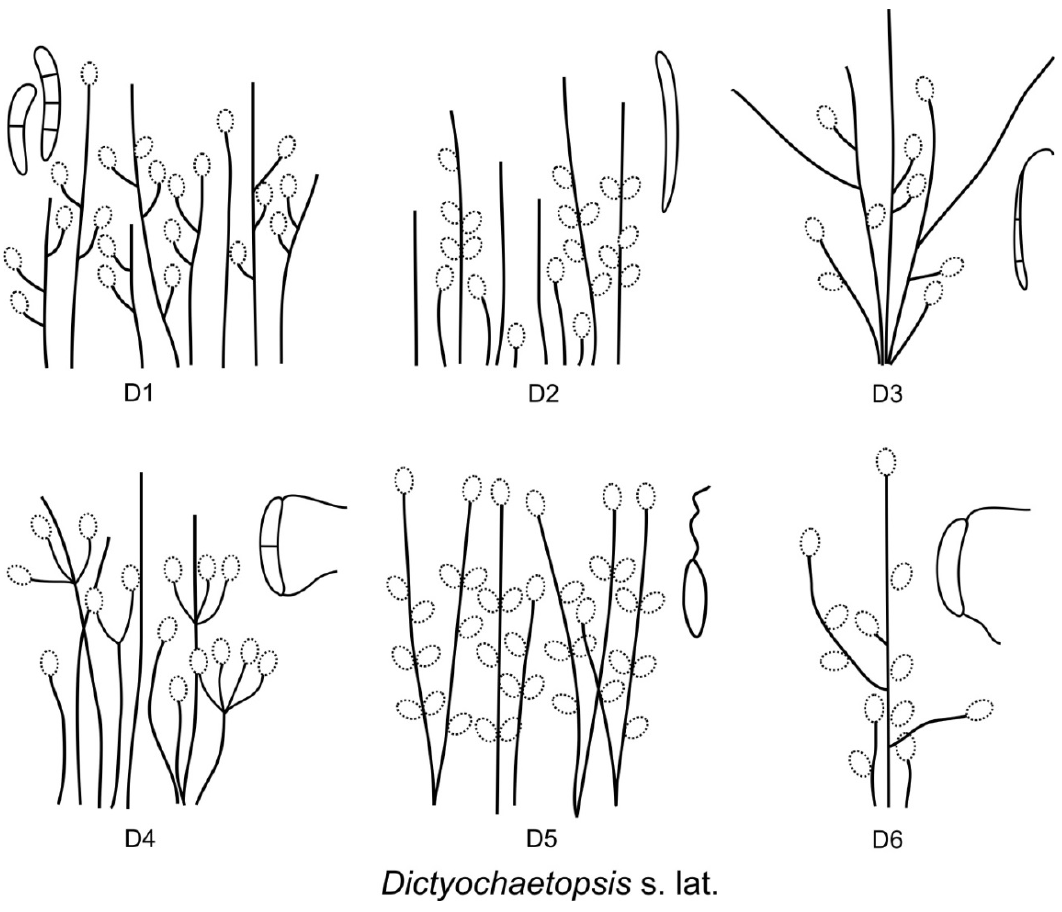
Figure 48. Morphotypes D1–D6 associated with Dictyochaetopsis s. lat. Morphotypes D1: Di. apicalis , Di. glauconigra (= Dictyochaetopsis s. str.), D2: Di. antillana , Di. maharashtrensis , D3: Di. hamata , D4: Di. dingleyae , D5: and D6: Di. elegantissima , Di. intermedia and Di. menisporoides .